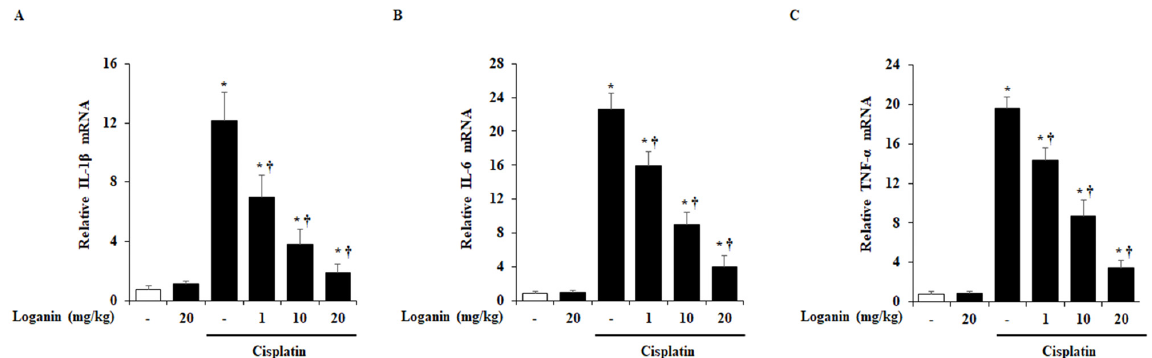
Figure 4. Effect of loganin on mRNA levels of pro-inflammatory cytokine in cisplatin-induced AKI. mRNA levels of ( A ) interleukin (IL)-1 β , ( B ) IL-6, and ( C ) tumor necrosis factor (TNF)- α were detected by real-time PCR. Each experiment was repeated 3 times. Data are represented as mean ± SEM ( n = 9). An * indicates p < 0.05 vs. saline-treated control group; † indicates p < 0.05 vs. cisplatin treatment alone.